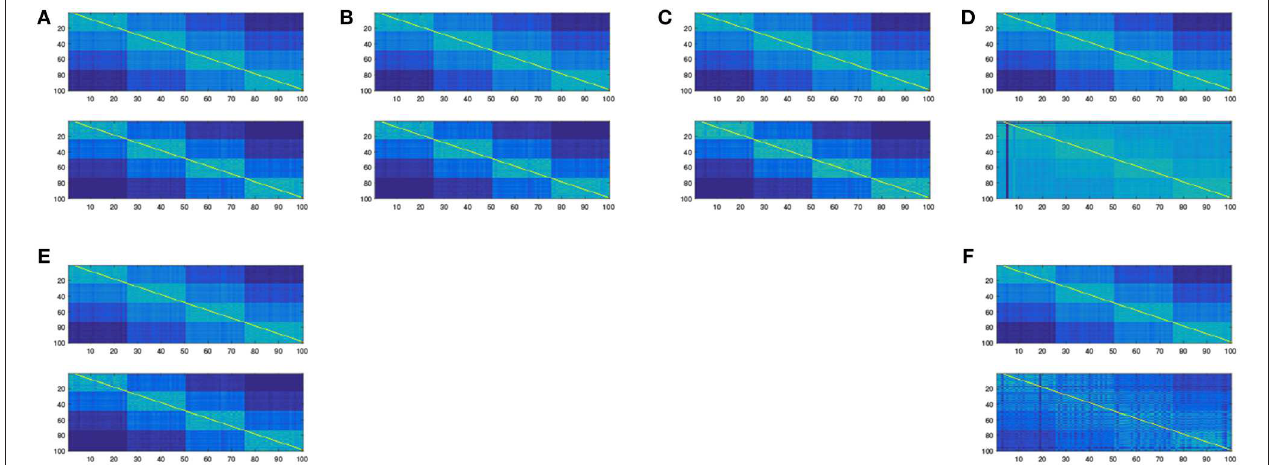
FIGURE 3 | The affinity matrix obtained after embedding using different methods from the Matlab package drtoolbox https://lvdmaaten.github.io/drtoolbox/. (A) Original affinity matrix vs. affinity matrix after PCA embedding. (B) Original affinity matrix vs. affinity matrix after MDS embedding. (C) Original affinity matrix vs. affinity matrix after Factor Analysis embedding. (D) Original affinity matrix vs. affinity matrix after t-SNE embedding. (E) Original affinity matrix vs. affinity matrix after Sammon embedding. (F) Original affinity matrix vs. affinity matrix after LLE